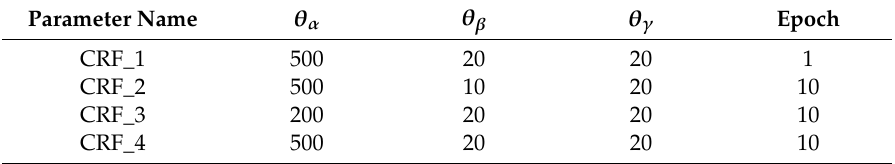
Table 5. Parameters of the four CRF (Conditional random filed)